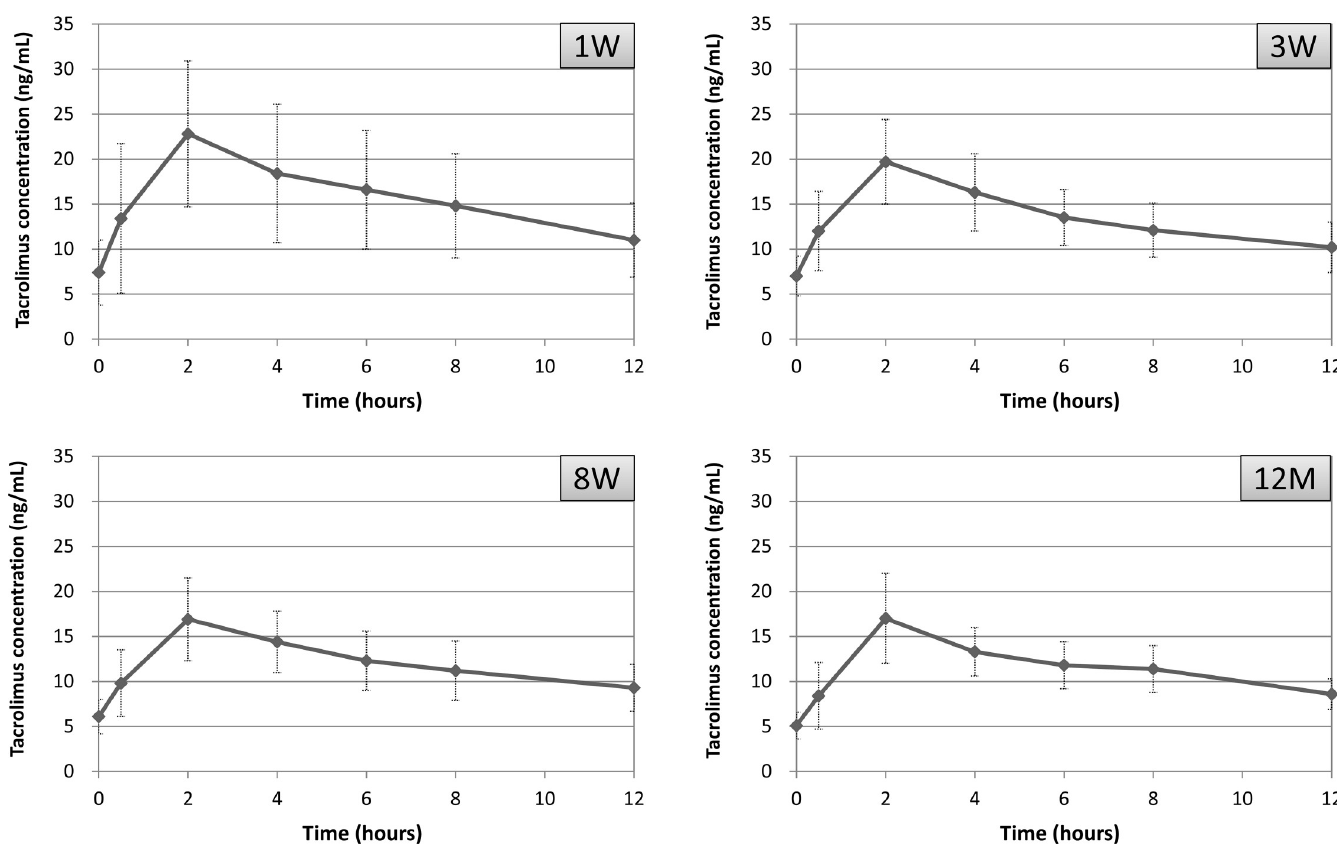
Fig 2. Concentration-time curves of the study group patients at post-operative 1 week, 3 weeks, 8 weeks and 12 months. The x-axis represents time points after oral administration of once-daily tacrolimus. The y-axis represents the whole-blood mean (SD) tacrolimus level. On most of the curves, blood tacrolimus concentrations rose to maximum levels (C max ) at 2 hours post-administration and gradually decreased thereafter. Numbers of profiles at post-operative 1 week, 3 weeks, 8 weeks and 12 months were 22, 22, 16, and 19,